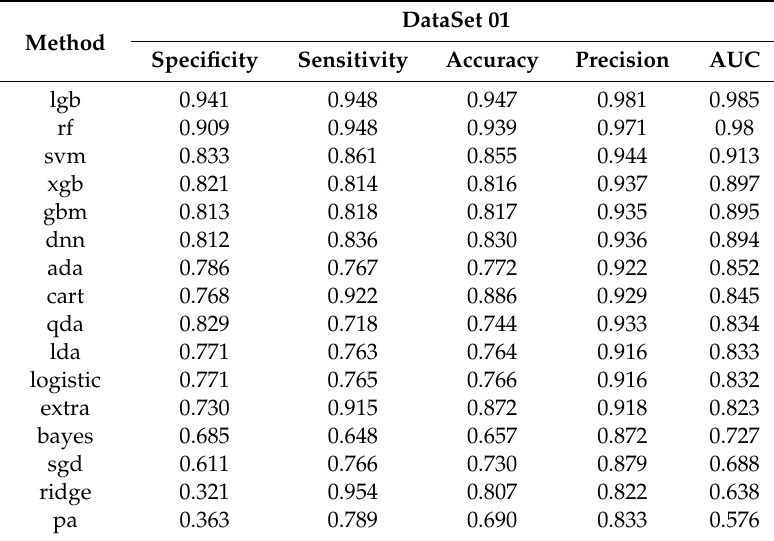
Figure 4. ( a ) Histograms and summary statistics of the seismic and ( b ) non-seismic input sample data. The figure shows the values of each frequency band (displays numerical data by grouping data into “bins” of equal width), and the percentage is that of the counts of each bin divided by the sum of counts of all bins. Table 2. Performance comparison between 15 spot-checking algorithms along with the deep neural network (DNN)method on the training dataset of DataSet